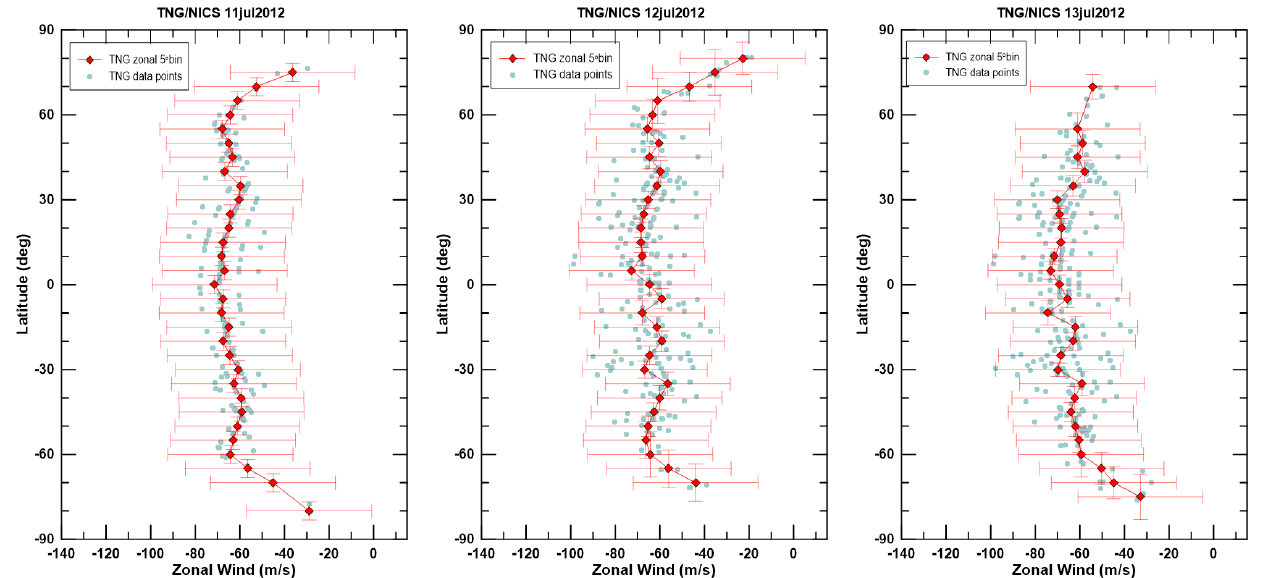
Figure 9. Latitudinal profile of the zonal wind velocities measured with cloud tracking using TNG/NICS infrared images in the wavelength window at 2.28 µ m, probing the bottom of the cloud deck of the nightside of Venus. From left to right, we present zonal wind results retrieved from our observations from 11 to 13 July 2012. The light-blue dots show the results related to each pair of tracers, and the red diamonds show the velocities averaged in a binning of 5 ◦ in latitude. Dynamics of the Nightside Lower Clouds with TNG/NICS